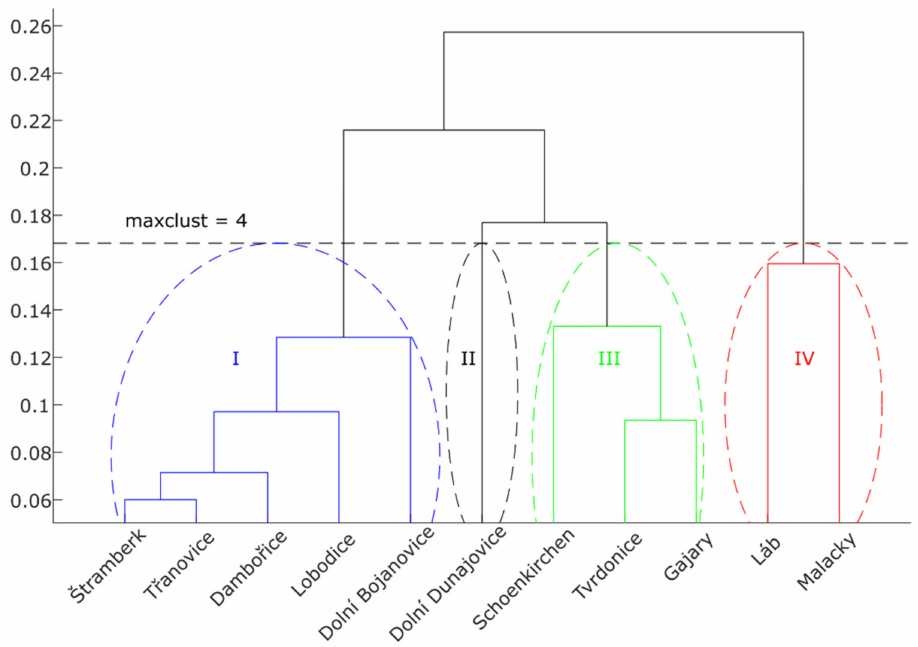
Figure 11. Hierarchical clustering of histograms for individual UGSs and UGS regions, with Clusters I to IV